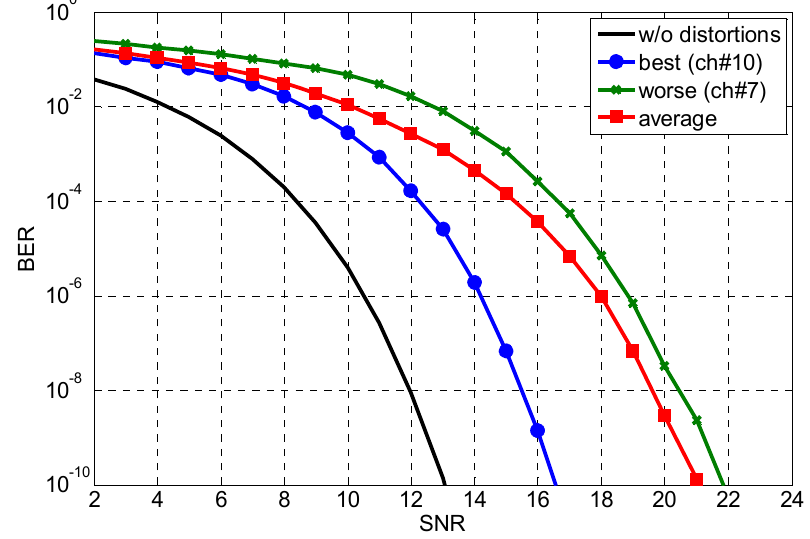
Figure 8. BER vs. SNR for transmission at 10 Gb/s of NRZ-OOK channels with roundtrip loss α = 0. The best performance was obtained for channel #10, the worse for channel #7 and the average considering the mean over the 32